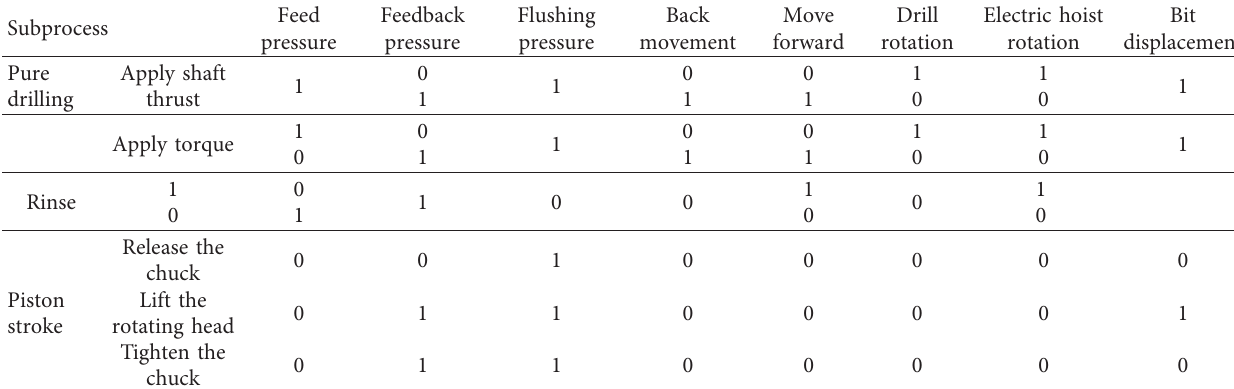
Table 4: The status of each working parameter of the drill pipe drilling